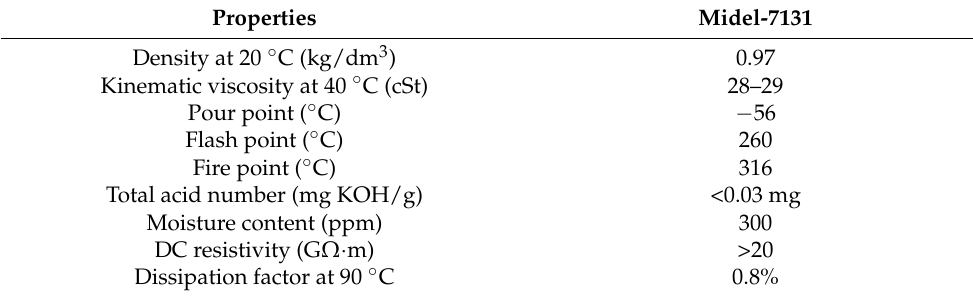
Table 1. Physiochemical properties of bare fluid (Midel-7131)